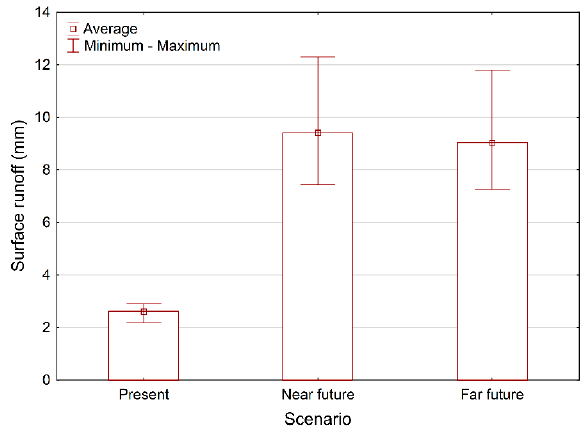
Figure 9. Surface outflows from drained arable land as a result of the current situation and for the near and far future. Bar charts with error bars show the average values, as well as the minimum and maximum values for the years 2014, 2017, and 2018.